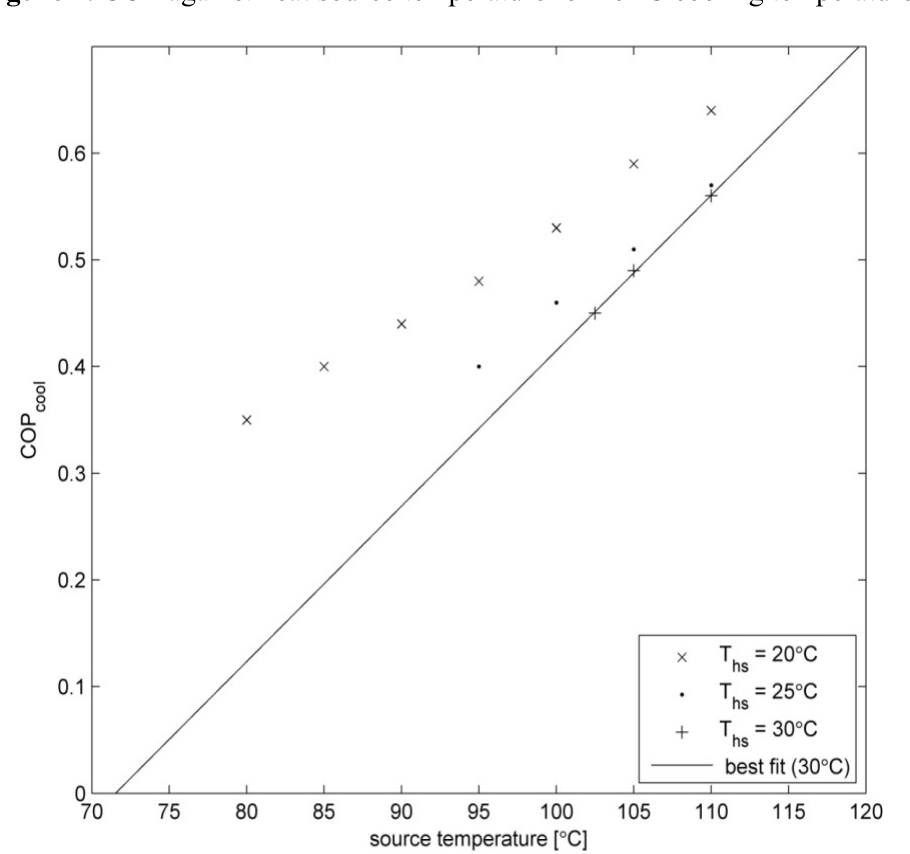
Figure 4. COP against heat source temperature for 18 °C cooling